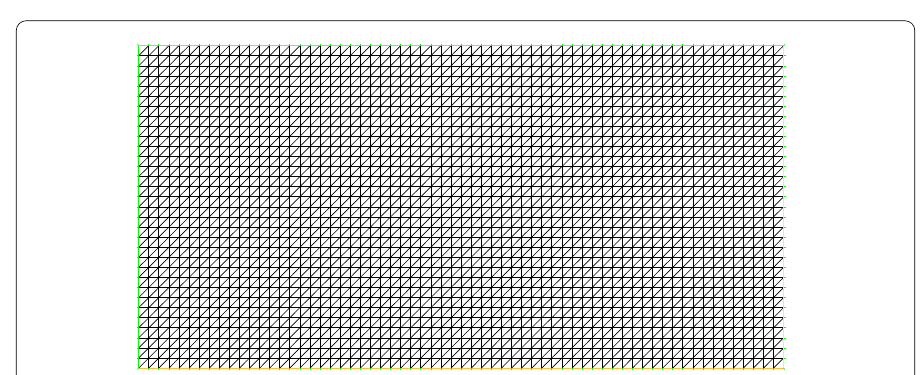
Figure 2 The mesh partition of